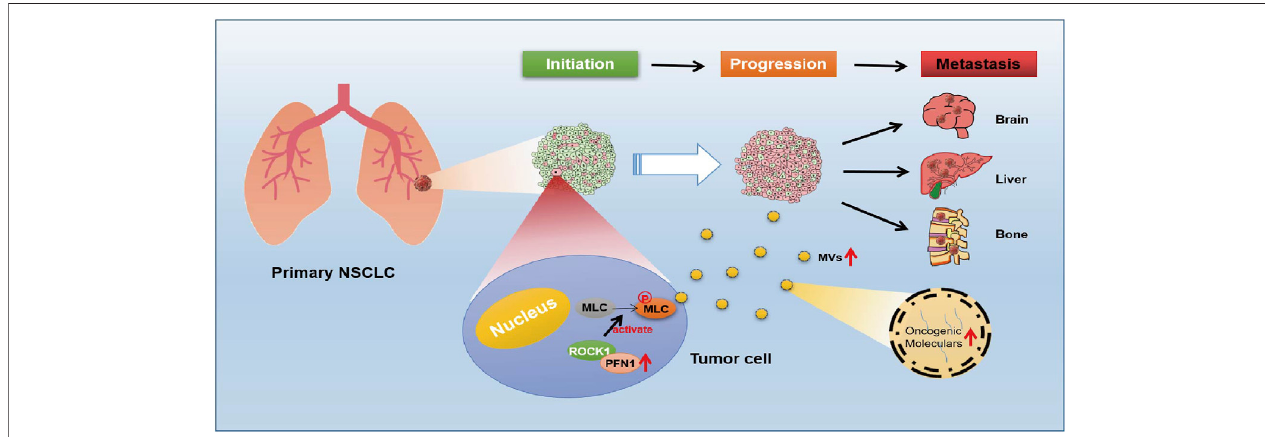
FIGURE 7 | Schematic diagram of the role of PFN1 in NSCLC metastasis. In the initiation stage of NSCLC, cells with upregulated PFN1 secret more MVs through PFN1 interactions with the ROCK/p-MLC pathway. These MVs contain numerous oncogenenic moleculars, which could enhance migration abilities of PFN1 normal expressed NSCLC cells, and untimately promote progression and metastasis of